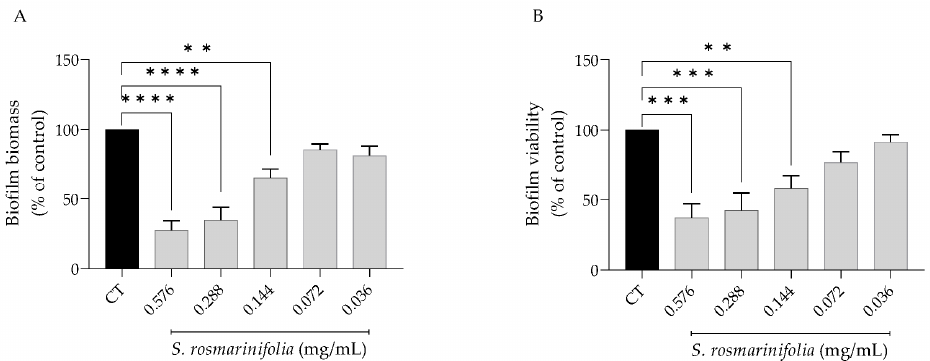
Figure 3. Santolina rosmarinifolia essential oil inhibited biofilm formation 48 h post-seeding. ( A ) Biofilm mass as measured by crystal violet assay. ( B ) Biofilm viability as assessed by XTT metabolization assay. Results show the mean ± SEM of five independent assays made in duplicate. ** p < 0.01, *** p < 0.001 and **** p < 0.0001 when compared to control (CT).